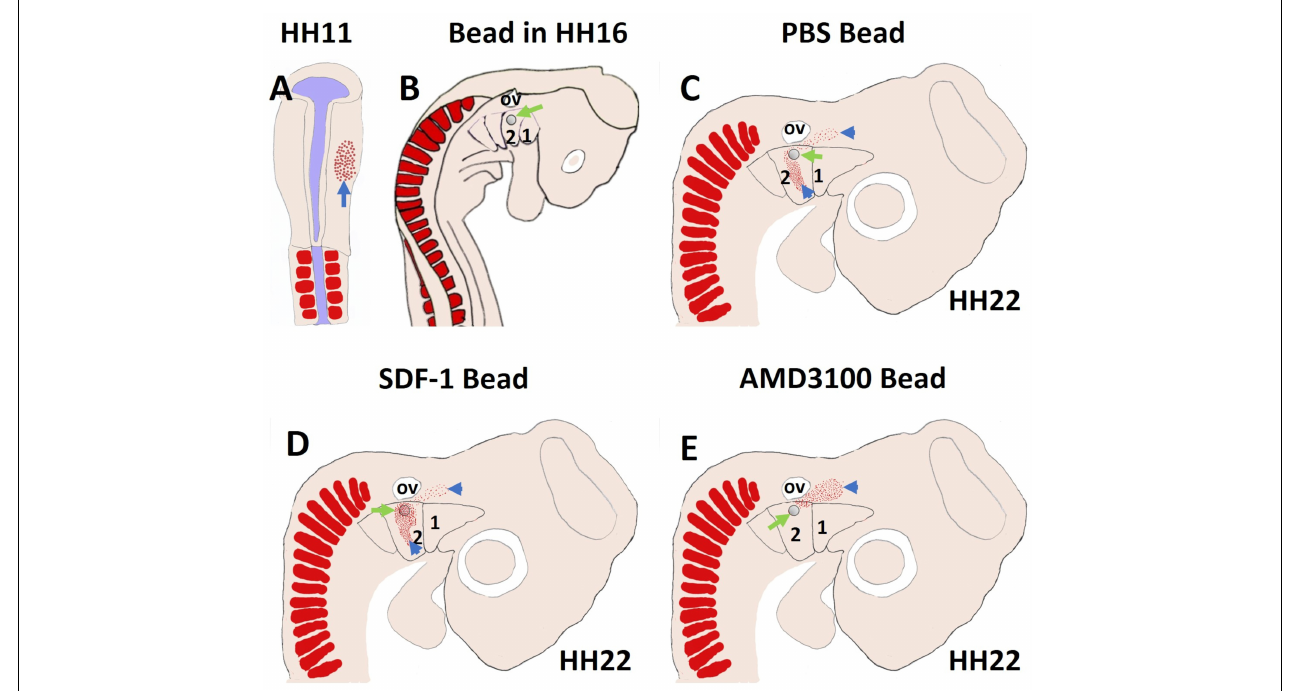
FIGURE 7 | SDF-1 guides the migration of the second arch-derived muscle progenitor cells. To further test the role of CXCR4 in early head muscle development, we injected quail cells into the right side of the head mesoderm of recipient chicken embryos at HH11 (A) followed by AMD3100, SDF-1 or PBS beads implantation (B) . The quail cells emigrated from the head mesoderm and populated BA2 of hosts. The quail cells were traced by whole-mount immunostaining for QCPN (C–E) . Whole-mount immunostaining revealed that the positive quail cells were prevented from entering the BA2 in AMD3100 implanted embryos, but not PBS-treated embryos. In the case of SDF-1 treated embryos, the quail cells were expanded and